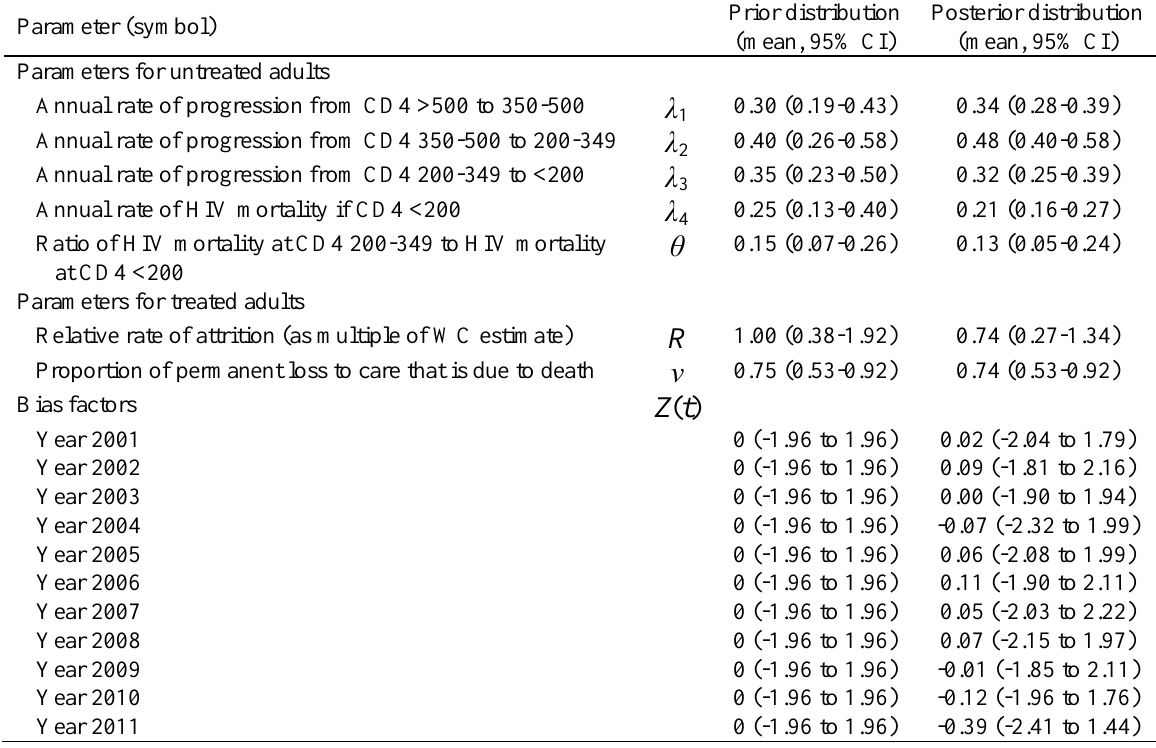
Table 5: Comparison of prior and posterior distributions Parameter